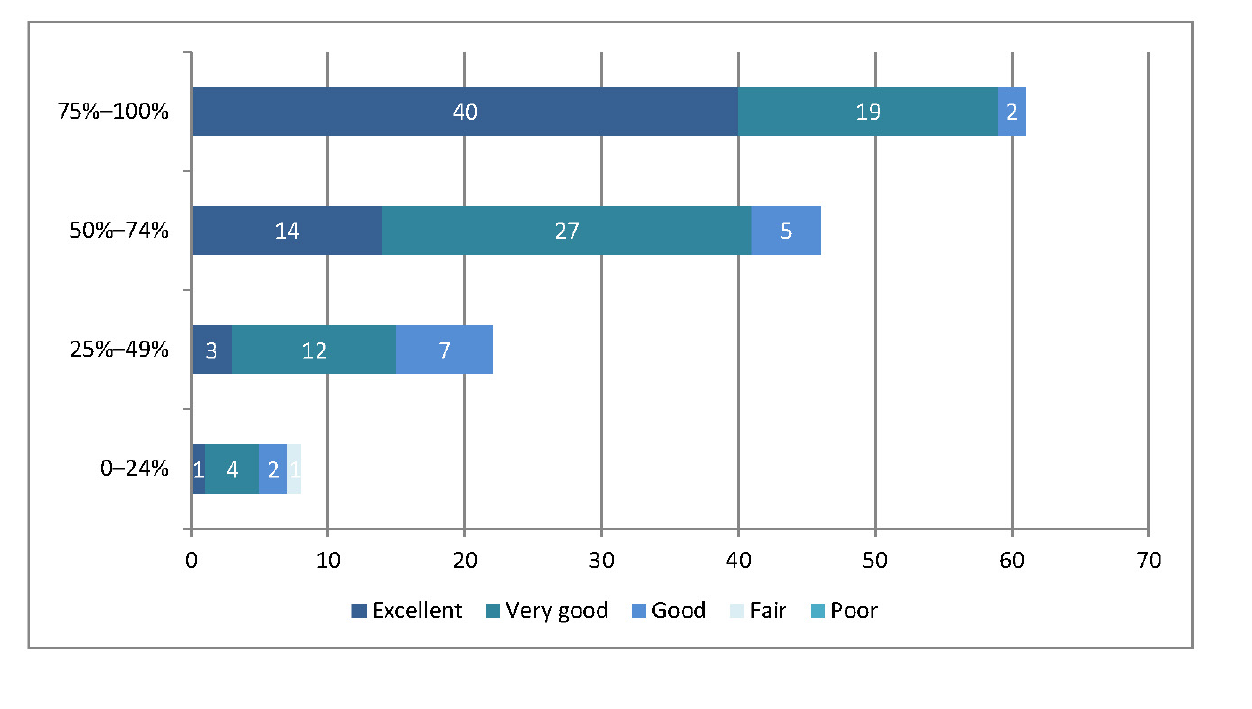
Figure 4 Usefulness of the search results by percentage of relevant search